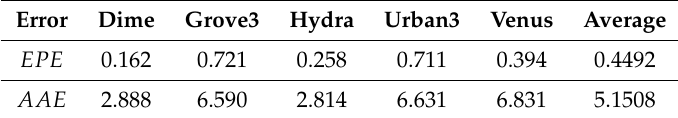
Table 6. The reported performance of TV-L1 in Middlebury